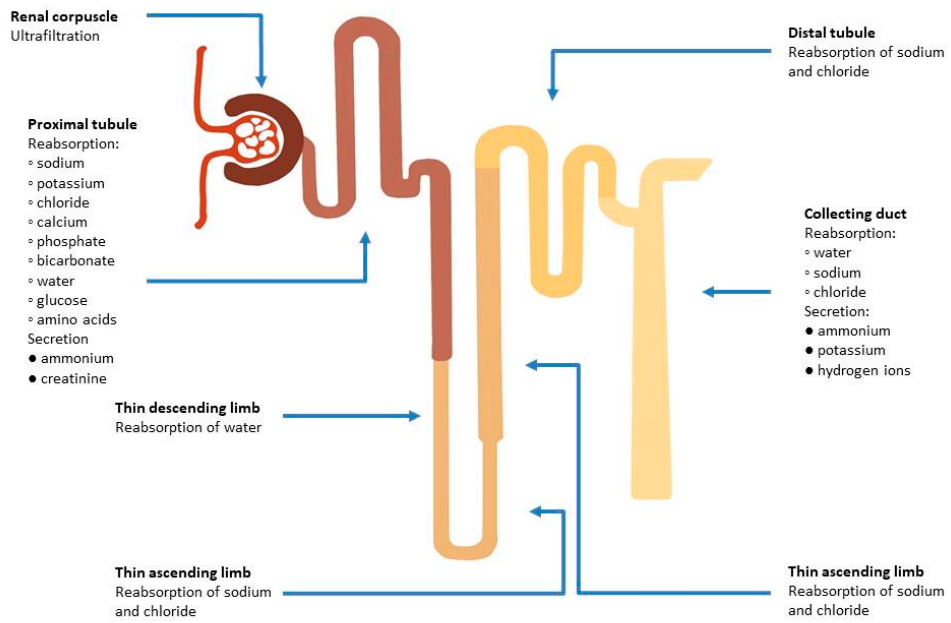
Figure 2. Functions of different parts of the nephron in maintaining fluid and electrolyte balance. Neutrophil gelatinase-associated lipocalin (NGAL) is a molecule involved in innate immunity. The primary function of NGAL is in sequestering bacterial siderophores, thus limiting iron usage by bacteria and slowing their growth. It is secreted by neutrophils during bacterial infections and to some extent by organs including the kidney, prostate, gastrointestinal and respiratory tracts [69]. It can be found both in serum and urine and it increases in AKI [70]. There are biased data on the prognostic value of NGAL. Previous observations made on enrolled HF patients suggested an association with WRF and adverse outcome [71–76]; however, the largest, multicenter cohort study to date does not support the routine use of serum NGAL for early detection of WRF in AHF treated with diuretic agents. According to the AKINESIS trial, serum NGAL has not been shown to be superior to creatinine in predicting adverse in-hospital outcomes and WRF [77]. On the other hand, studies have implicated that tubular damage might occur in the absence of an increase in serum creatinine, opening up a possibility of early detection of renal injury and timelier deployment of therapy, suggesting that the definition of AKI should be re-assessed [78,79] (Figure 3). A study on urinary NGAL has shown that it can identify high-risk ADHF patients, and predict WRF and early outpatient mortality. Moreover, it has been reported that in a longer, 1-year follow-up period, increased urinary NGAL may predict the risk of HF rehospitalization [80]. It should be noted that NGAL may be overexpressed in conditions of hypertension, hypoxemia, infections, anemia and malignancies, which are greatly prevalent among patients with HF [81–85].